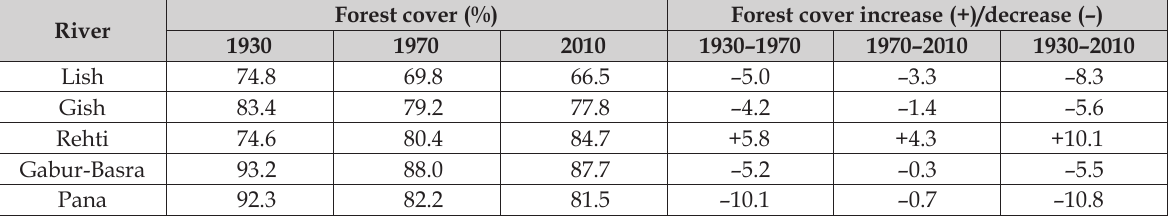
Table 3. Forest cover and its changes in mountain